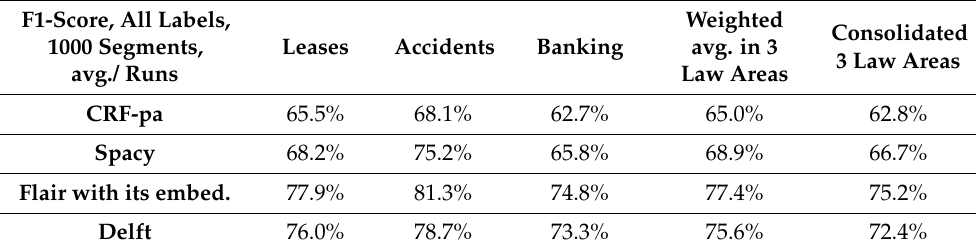
Table 8. Quality by law area: lower-court